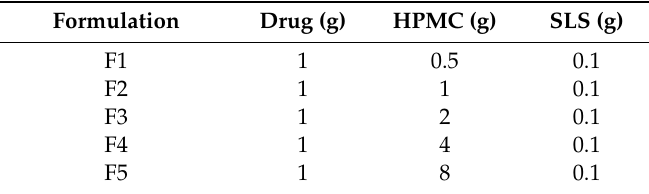
Table 1. Composition of various solid dispersions prepared using various polymer-to-surfactant ratios.